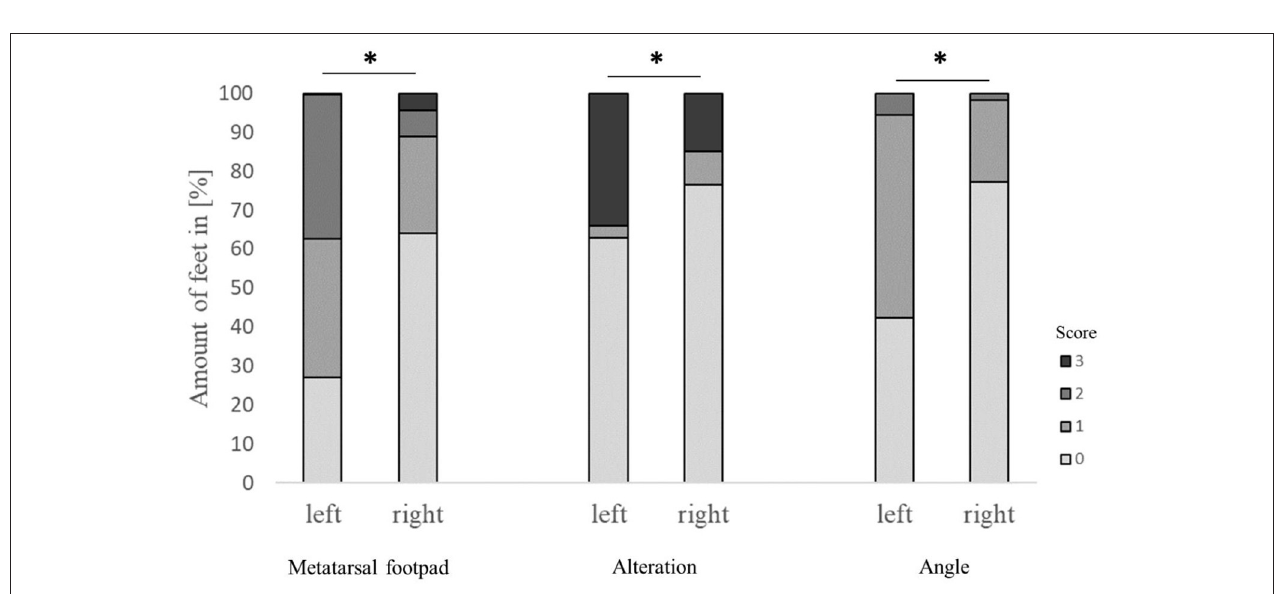
FIGURE 4 | Effect of the laterality (scoring on left or right foot) on the performance in detecting the metatarsal footpad, alterations, and the angle of presentation. Data are presented as the number of feet in percent for the respective scores with increasing gray levels indicating an increasing score level (light gray = scoring level 0–dark gray scoring level 3; see Table 2 for the explanation of scoring levels); * p < 0.05; the number of feet for the detection of the metatarsal footpad: left = 2,412, right = 2,717; the number of feet for the detection of the alteration: left = 2,401, right = 2,714; the number of feet for the angle of presentation: left = 2,417, right =